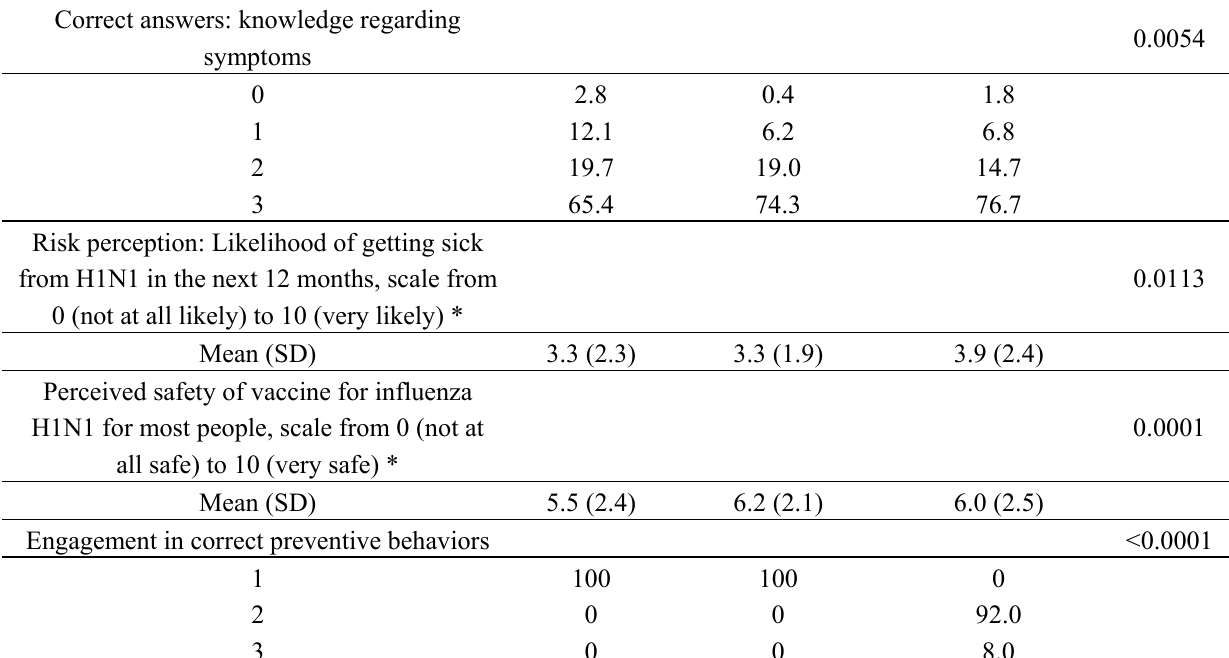
Open to Informed Disengaged Persuasion Unconvinced Skeptics p -value Cluster ( n = 163) Cluster ( n = 226) ( n = 777) (%) (%) (%)